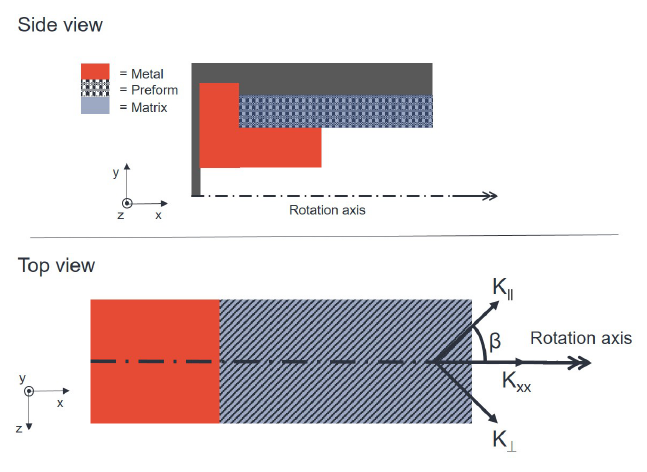
Figure 9. Axial permeability based on [10]. Table 6. Permeability values for axial permeability (x-direction) and radial permeability